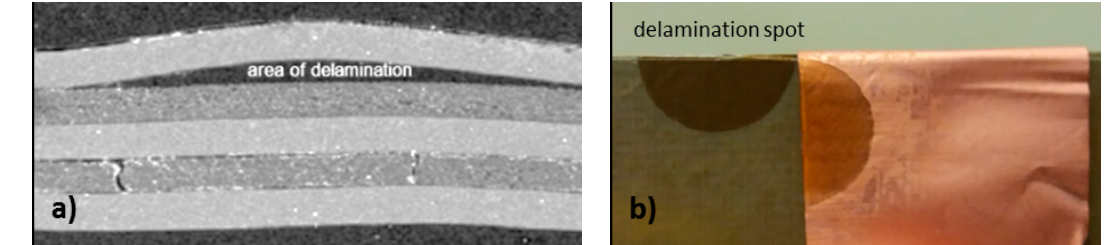
Figure 9. Cu/epoxy delamination failures after reliability testing. An SEM image of the cross section ( a ) and a photographic image after peeling ( b ) are shown.